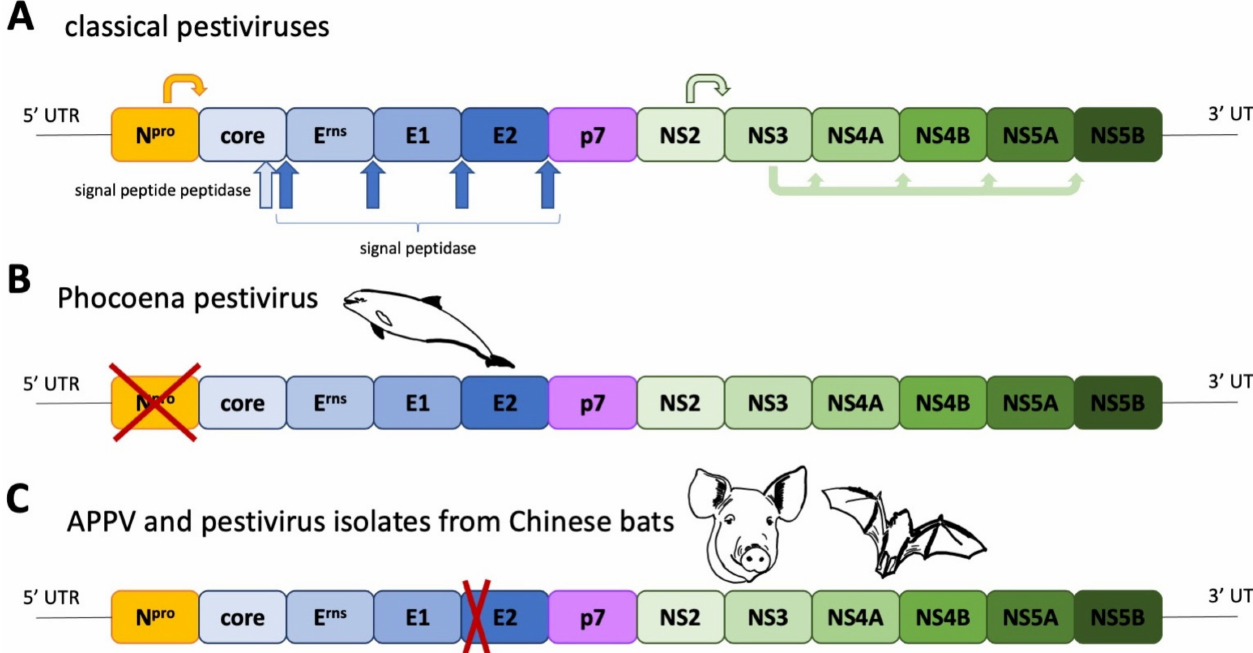
Figure 1. ( A ) Pestivirus genome organisation, polyprotein processing and special traits of viruses isolated from harbour por- poises ( B ) as well as swine and bats ( C ). The structural proteins are coloured in shades of blue. NS = non-structural